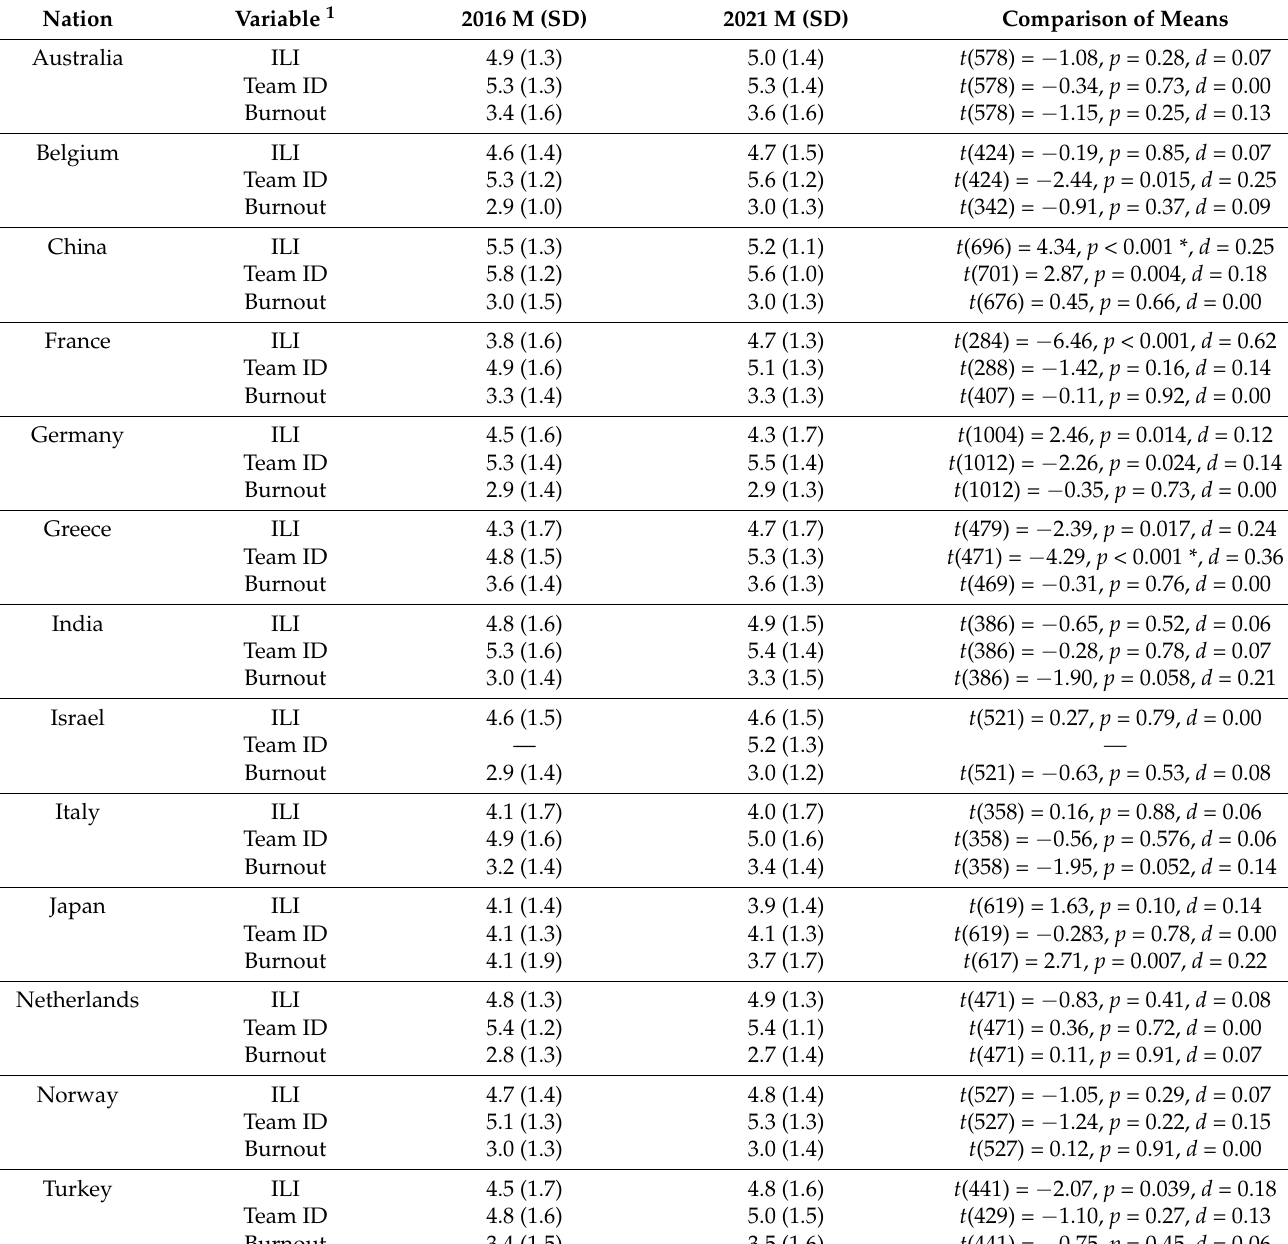
Table 4. Means and standard deviations of main variables in 2016 and 2021 per nation; t -test for independent samples.